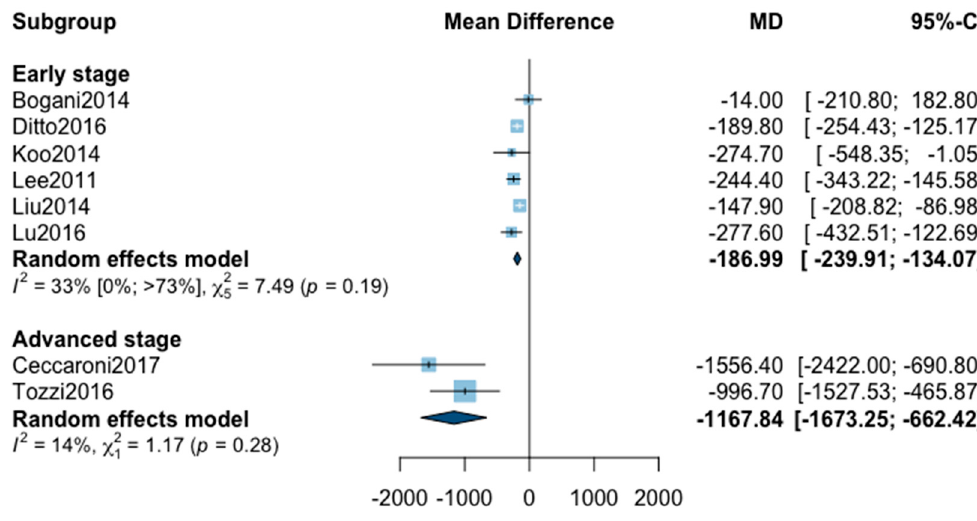
Figure A3. Meta ‐ analysis for estimated blood loss .